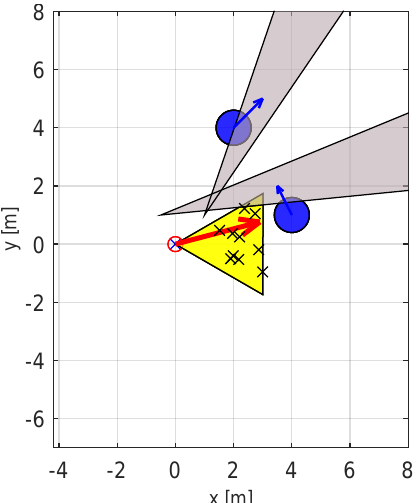
Figure 4. VO − type diagram of the sparse scenario. The robot is positioned in the origin and is denoted by a red circle. The yellow area represents the reachable available velocities, with the red arrow being the optimal velocity corresponding to the fastest solution. The blue disks represent the obstacles with their velocities, while the gray triangles are the corresponding VOs. The x-marks distributed within the area of reachable velocities are the initial population of the GAVO variants. The fact that the area of reachable velocities only minimally overlaps with any VO shows that this is an “easy” scenario.